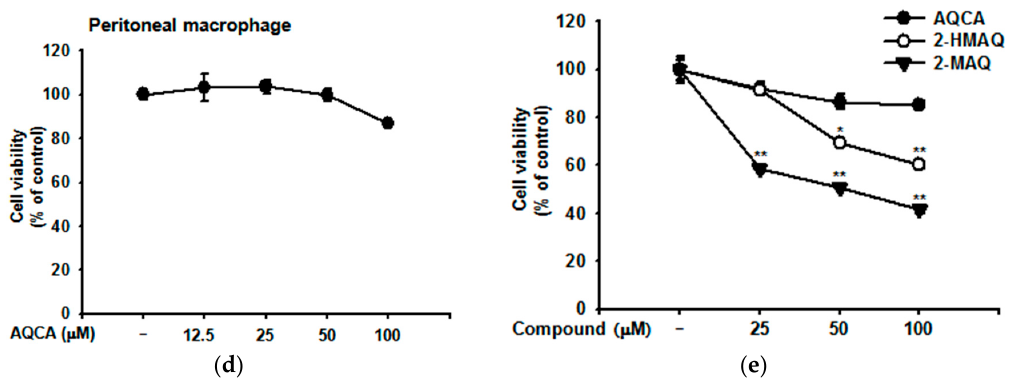
Figure 1. Effect of anthraquinone-2-carboxlic acid (AQCA) on the production of nitric oxide (NO) and prostaglandine E 2 (PGE 2 ) in macrophages and cell viability. Peritoneal macrophages (2 × 10 6 cells/mL) or RAW264.7 cells (1 × 10 6 cells/mL) were treated with lipopolysaccharide (LPS) (1 μ g/mL) in the presence or absence of AQCA, 2-hydroxymethylanthraquinone (2-HMAQ), or 2-MAQ for 24 h. ( a – c –left panel) Concentrations of NO or PGE 2 in the culture supernatants were determined using the Griess assay and enzyme immunoassay (EIA); ( c –right panel) Chemical structures of AQCA, 2-HMAQ, and 2-MAQ; ( d – e ) Peritoneal macrophages or RAW264.7 cells were treated with AQCA (0 to 100 μ M) for 24 h, respectively. Cell viability was evaluated using the (3-4,5-dimethylthiazol-2- yl)-2,5-diphenyltetrazolium bromide, tetrazole (MTT) assay. All data are expressed as the mean ± SD of experiments performed with six samples. Similar inhibitory patterns were observed in two repeat experiments. * p < 0.05 and ** p < 0.01 compared to control (LPS alone) or normal (without LPS) groups.